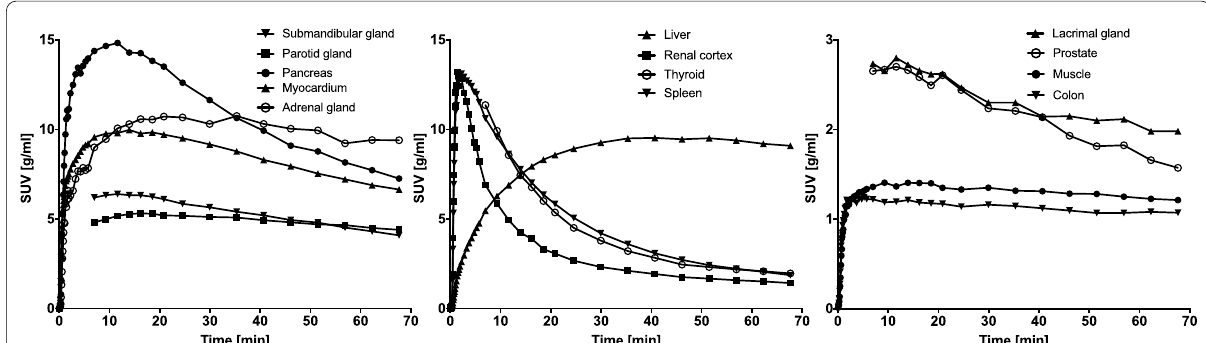
Fig. 3 Mean SUV time-activity curves for all organs investigated. Some organs only have data from 6 to 70 min post injection. Note that the thyroid, spleen and renal cortex show similar rapid washout, whereas all other organs display much slower washout